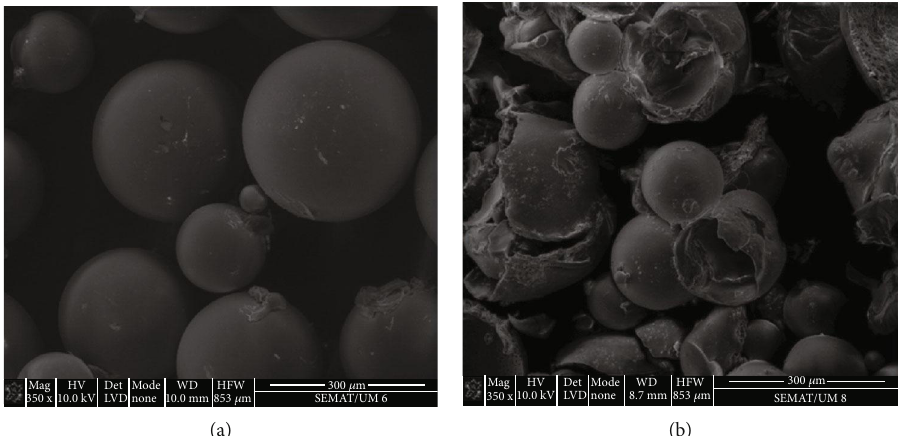
Figure 58: Scanning electron microscopy micrographs of citronella-loaded polyurethane microcapsules (a) before and (b) after mechanical stress [152].